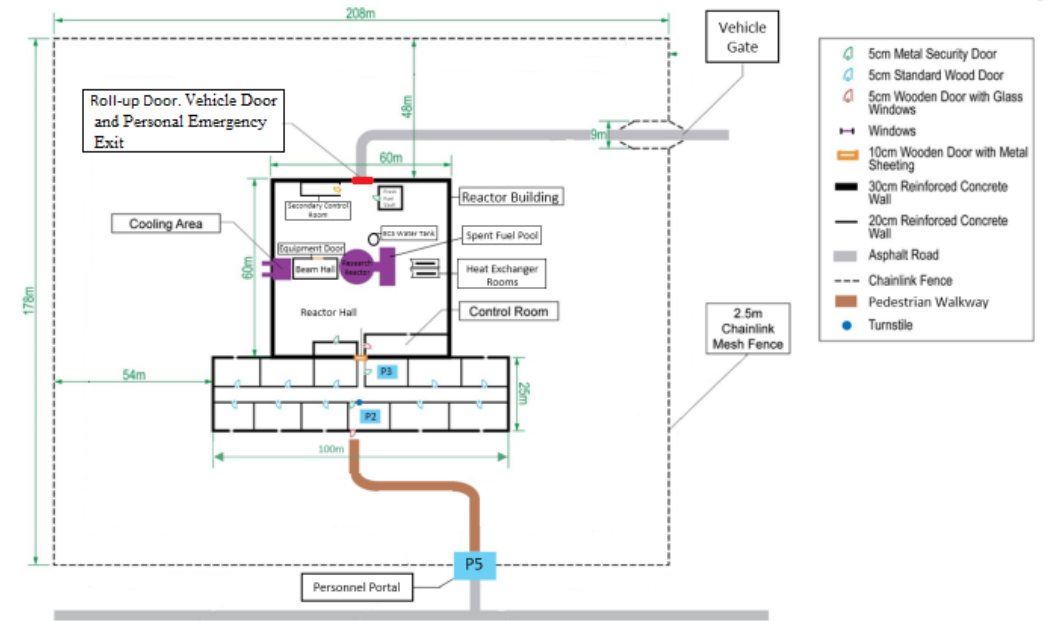
Figure 2. MTR wall thicknesses and distances as described in the data